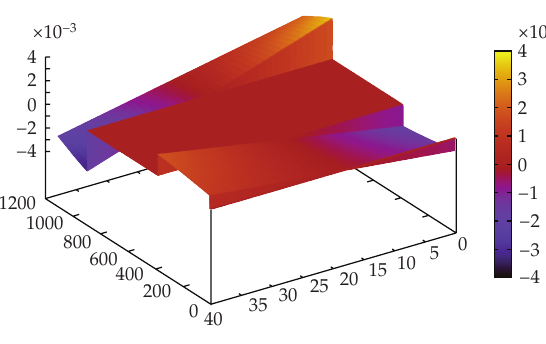
Figure 8: Distribution of ∂η/∂x .